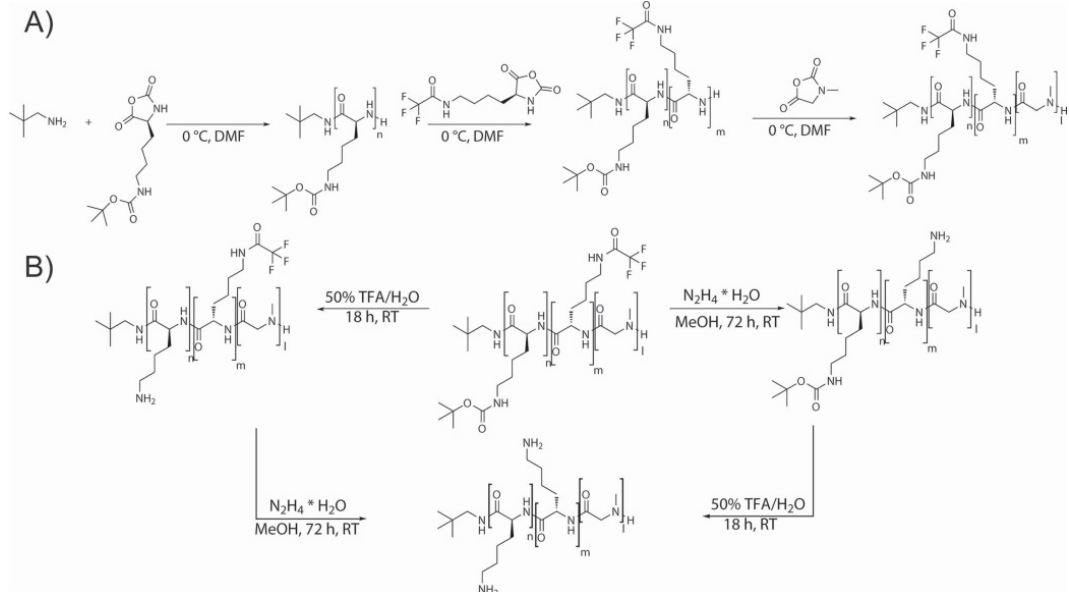
Figure 27. ( A ) Synthesis of PLys(Boc)-PLys(TFA)-PSar triblock copolymers by sequential ring-opening polymerization followed by ( B ) Block specific deprotection of the PLys blocks. Reproduced with permission from reference [124].